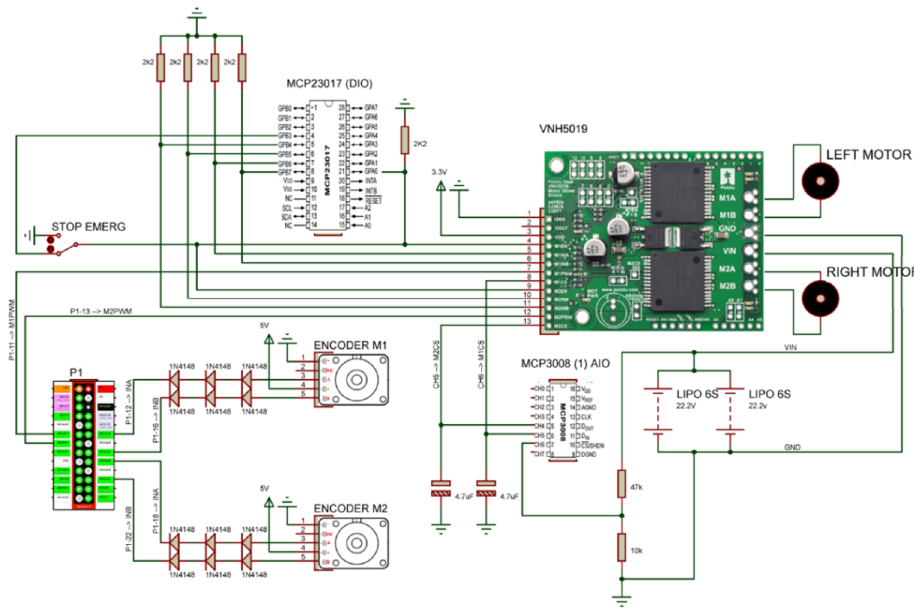
Figure 10. Diagram of the motor actuation and control circuit.